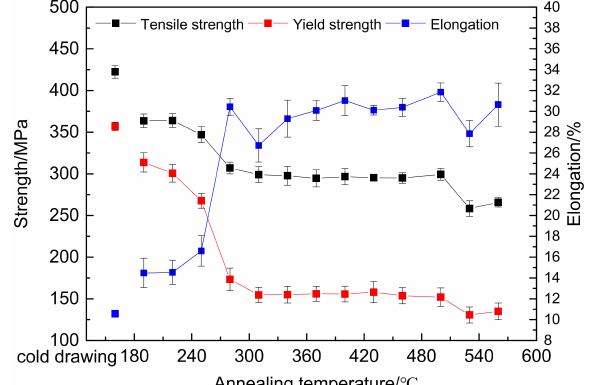
Figure 8. Tensile property curves of a cold-drawn 5056 aluminum alloy after annealing at differ- ent